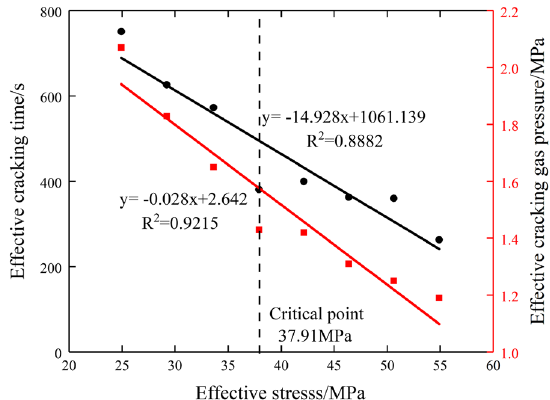
Fig. 7 Variation of effective cracking time and effective cracking gas pressure with critical gas pressure